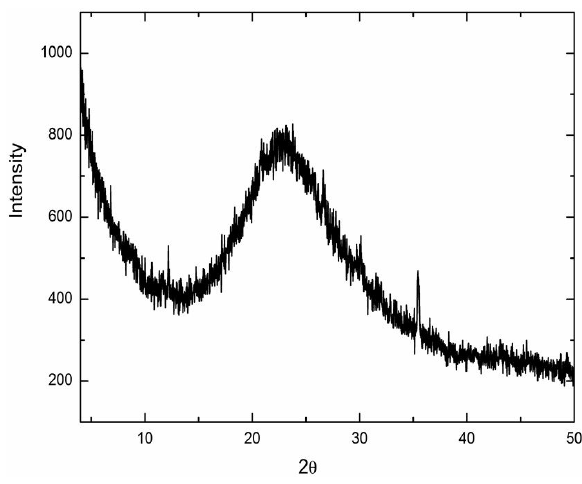
Figure 3: Wide Angle X-ray diffraction of silicon oxide nanofiber.